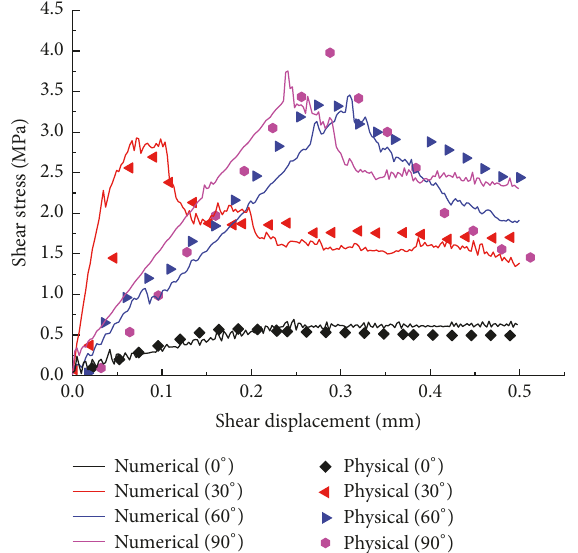
Figure 11: Comparison between the shear stress-shear displacement curves of the numerical and physical tests.